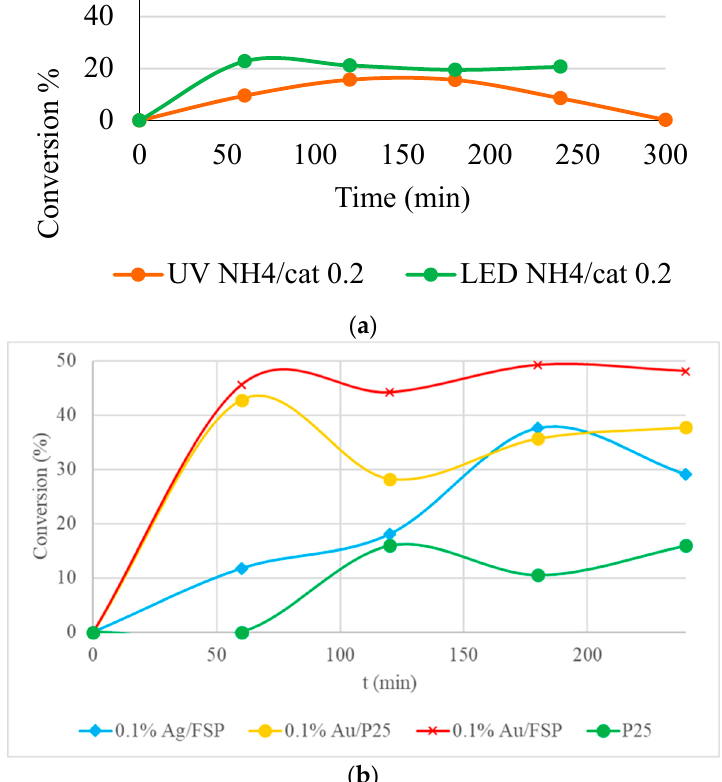
Figure 4. ( a ) Comparisons between the reaction performed with UV or LED lamps and with a 0.2 mol NH 4+ /g catalyst ratio, 0.1% Ag/FSP, pH 5, r.t. and 250 mL of solution. UV lamp irradiance was equal to 260 W/m 2 . ( b ) Comparison of selected photocatalysts under LED visible light irradiation.